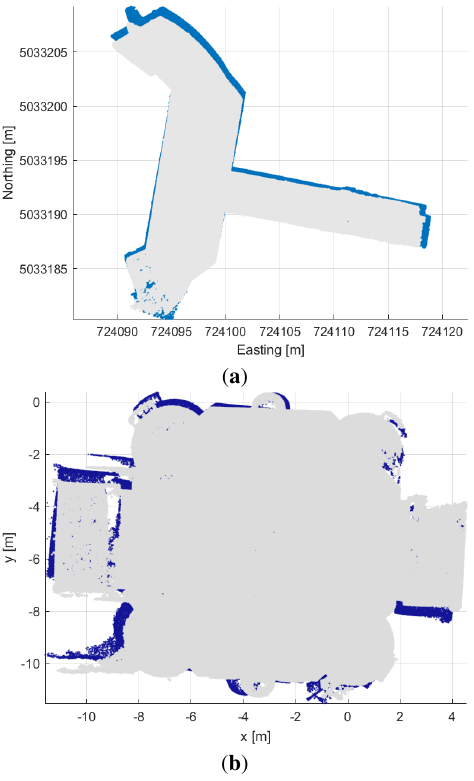
Figure 10. Top view of the correctly oriented point clouds (gray) and those oriented by means of IMU measurements. Case stud- ies: ( a ) Impossible bastion, ( b ) Savonarola